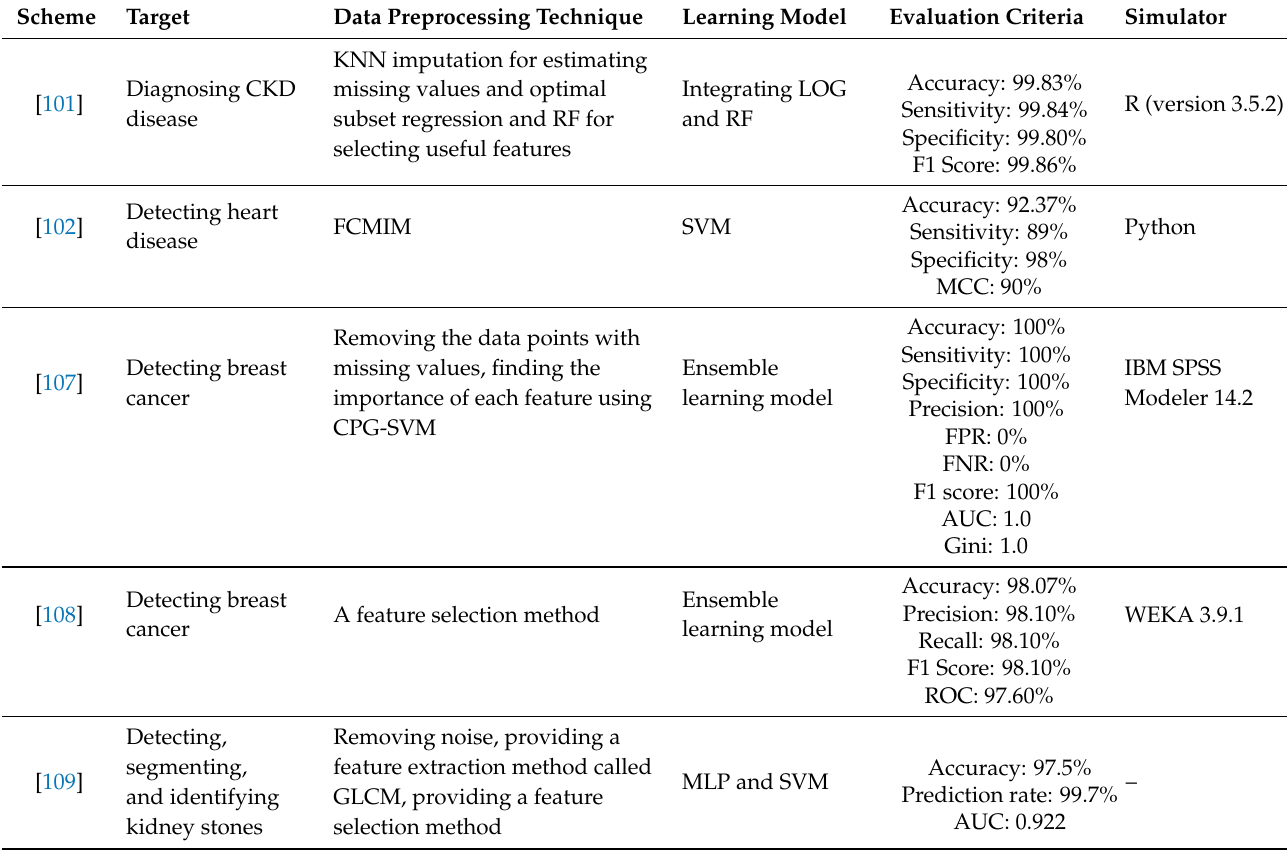
Table 8. The most important characteristics of supervised learning-based